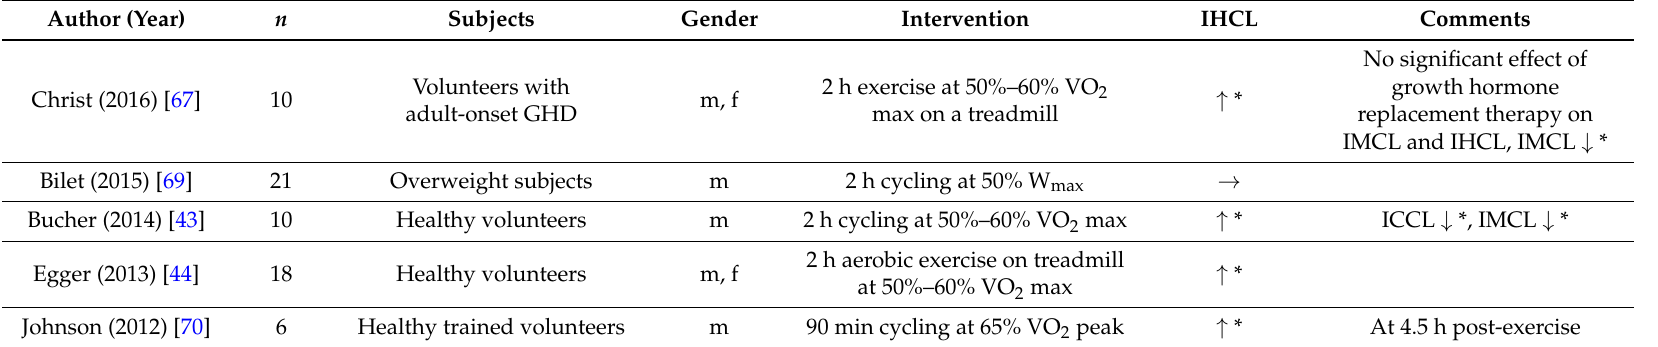
Table 2. Effect of short-term exercise on IHCL using 1